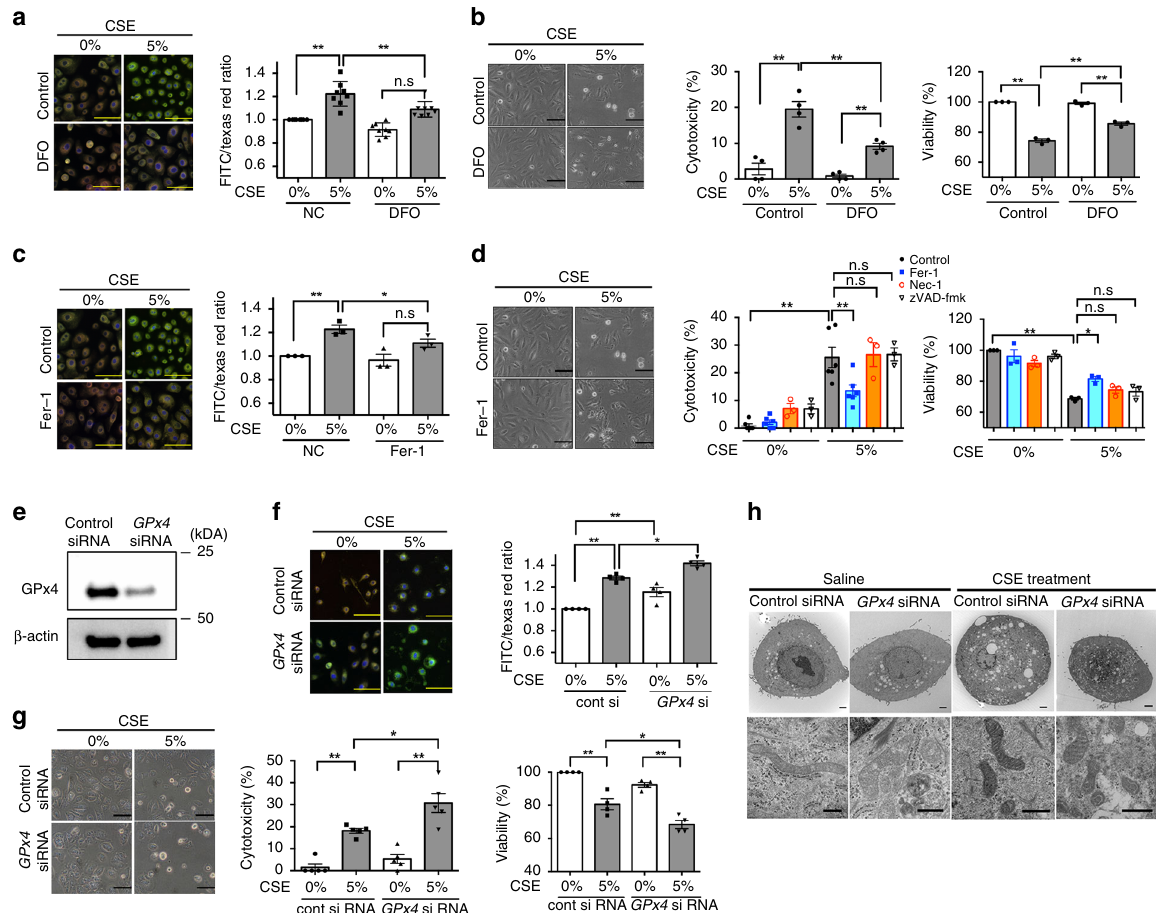
Fig. 1 CSE induces ferroptosis in Human bronchial epithelial cells (HBECs). HBECs were treated with 5% Cigarette smoke extract (CSE) for 24 h. Lipid peroxidation assay in HBECs using the lipophilic redox-sensitive dye BODIPY 581/591, which shifts its fl uorescence from red to green in response to oxidation. Scale bar = 100 µ m.Cell death was assessed by cytotoxicity using LDH assay and cell viability using MTT assay. a , b Saline or Deferoxamine (DFO) (100 µ M) was added to HBECs 1 hr before control or 5% CSE treatment. a Representative phase-contrast microscopy images of BODIPY581/ 591 staining are shown. Scale bar = 100 µ m. n = 8 independent experiments. b Representative phase-contrast microscopy images of HBECs, LDH assay ( n = 4 independent experiments), and MTT assay ( n = 3 independent experiments) are shown. c Saline or Ferrostatin-1 (10 µ M) was added to HBECs 1 h before control or 5% CSE treatment. Representative phase-contrast microscopy images of BODIPY581/591 staining are shown. n = 3 independent experiments. d Saline or Ferrostatin-1 (10 µ M) or Necrostatin-1 (50 µ M) or zVAD-fmk (20 µ M) was added to HBECs 1 h before control or 5% CSE treatment. Representative phase-contrast microscopy images of HBECs, LDH assay, and MTT assay are shown. e Western blotting (WB) showing expression levels of GPx4 and β -actin in HBECs transfected with control siRNA or GPx4 siRNA. f , g . HBECs were transfected with control siRNA or GPx4 siRNA 48 h before control or 5% CSE treatment. f Representative phase-contrast microscopy images of BODIPY581/591staining are shown. Scale bar = 100 µ m. n = 4 in each group. g . Representative phase-contrast microscopy images of HBECs, LDH assay, and MTT assay are shown. a , c , f Each panel shown represents the mean ± SEM of FITC/Texas Red ratio, taken from at least 3 independent experiments. * P < 0.05, ** P < 0.01 by one-way ANOVA followed by Tukey ’ s multiple comparisons test. b , d , g Each panel shown represents the mean ± SEM taken from at least 3 independent experiments. * P < 0.05, ** P < 0.01 by one-way ANOVA followed by Tukey ’ s multiple comparisons test. h Representative transmission electron microscopy(TEM) images of human bronchial epithelial cells transfected with control siRNA or GPx4 siRNA (top row). HBECs were treated with saline or 5% CSE for 24 h. Mitochondria are shown enlarged in bottom rows. Scale bars; 2 µ m (top row), 500 nm (bottom